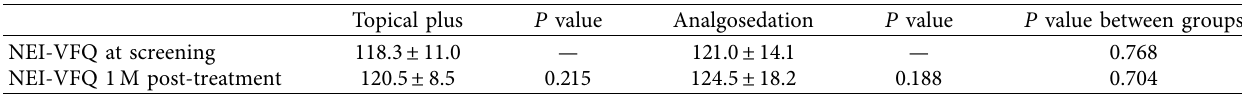
Table 3: Change in vision-related quality of life.